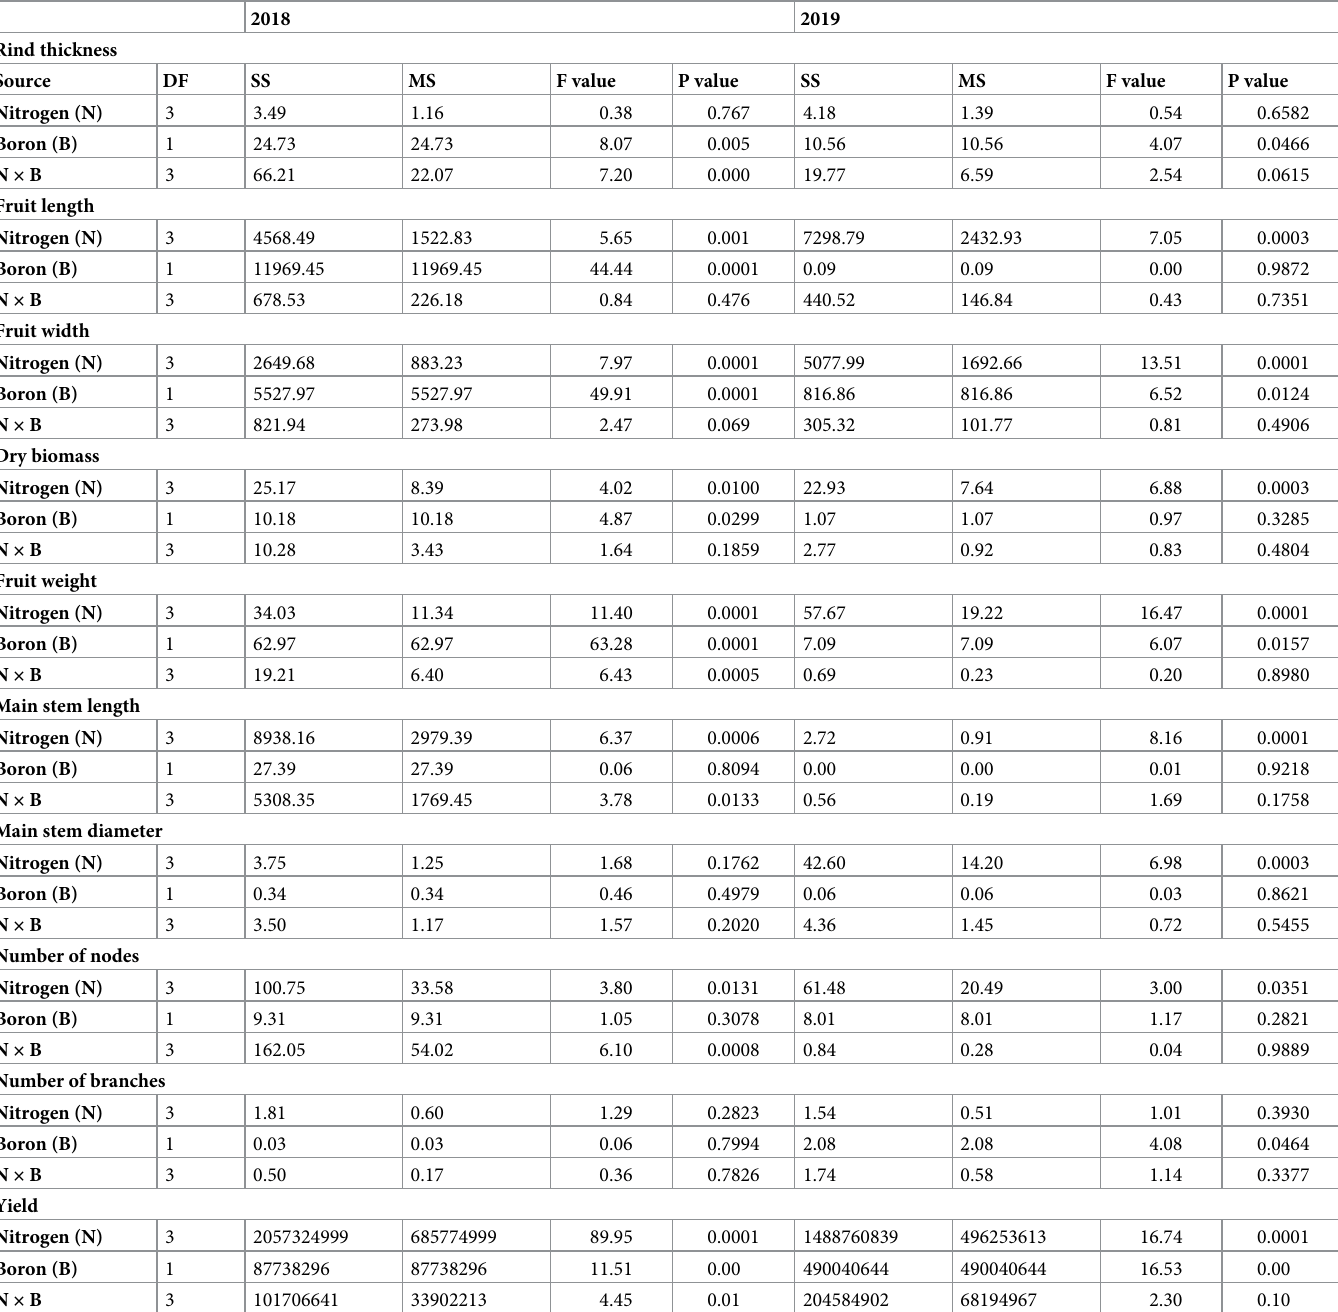
Table 1. Analysis of variance for different pomological traits of grafted watermelon grown under varying nitrogen and boron levels.